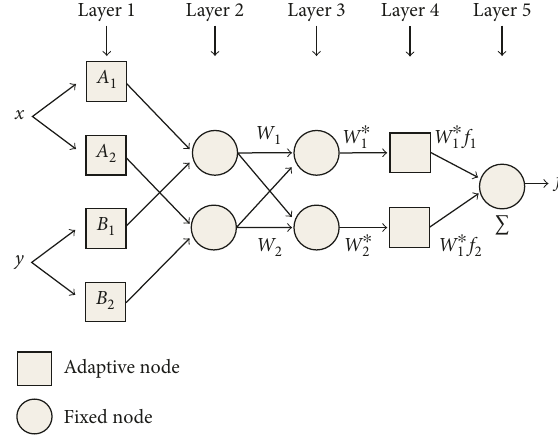
Figure 3: Typical ANFIS architecture for two inputs and one output.